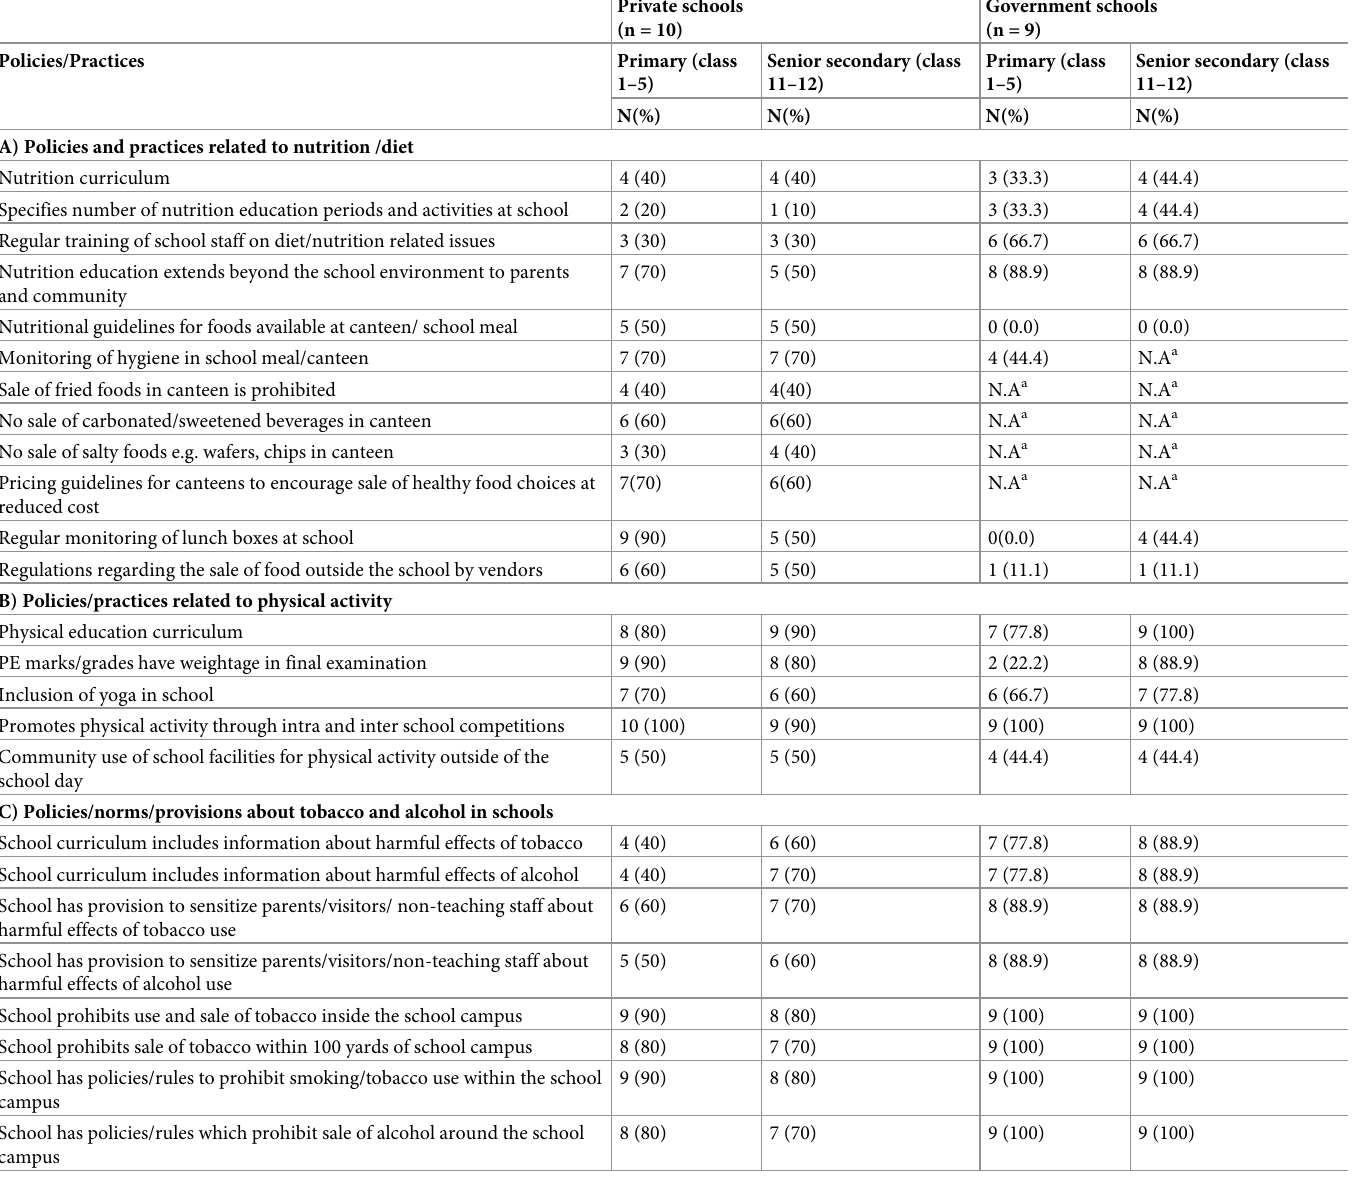
Table 2. School health policies and practices as reported by teachers (n =